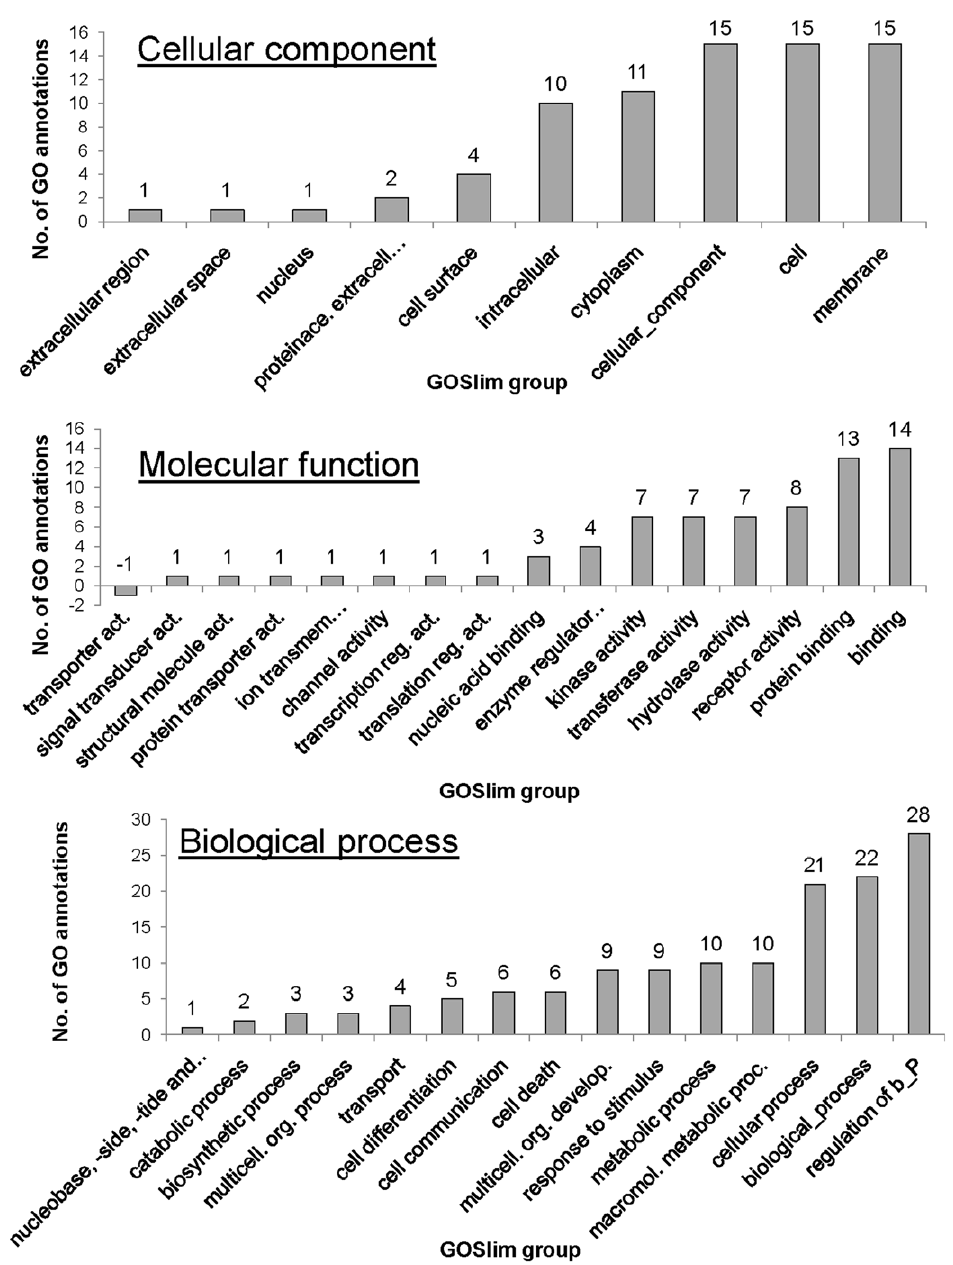
Figure 2. Differentially Expressed mRNA GOSlim modelling. The difference in number of GO annotations in the GOSlim groups for the GO ontologies ‘cellular component’, ‘molecular function’ and ‘biological process’ between the original and re-annotated differentially expressed mRNA dataset. The differentially expressed mRNA GOSlim modeling shows that re-annotation increases the number of GO annotations for most GOSlim group. The negative value for the GOSlim group ‘transporter activity’ in the ‘molecular function’ ontology are caused by updated GO annotations to the more detailed ‘protein transporter activity’ GOSlim group. variance. Fourteen pathways were unique to the re-annotated differentially expressed mRNA dataset. Table 5 and 6 lists the top 10 of the significant shared pathways identified in the original (Table 5) and re-annotated (Table 6) differentially expressed mRNA datasets. The mean pathway coverage ratio for the pathways (i.e. number of genes in datasets/total number of genes in pathway) represented for the original annotations is 0.018 but for the re-annotated data is 0.030 (i.e. 1.6-fold increased). Re- annotation improves canonical pathway coverage and shifts the